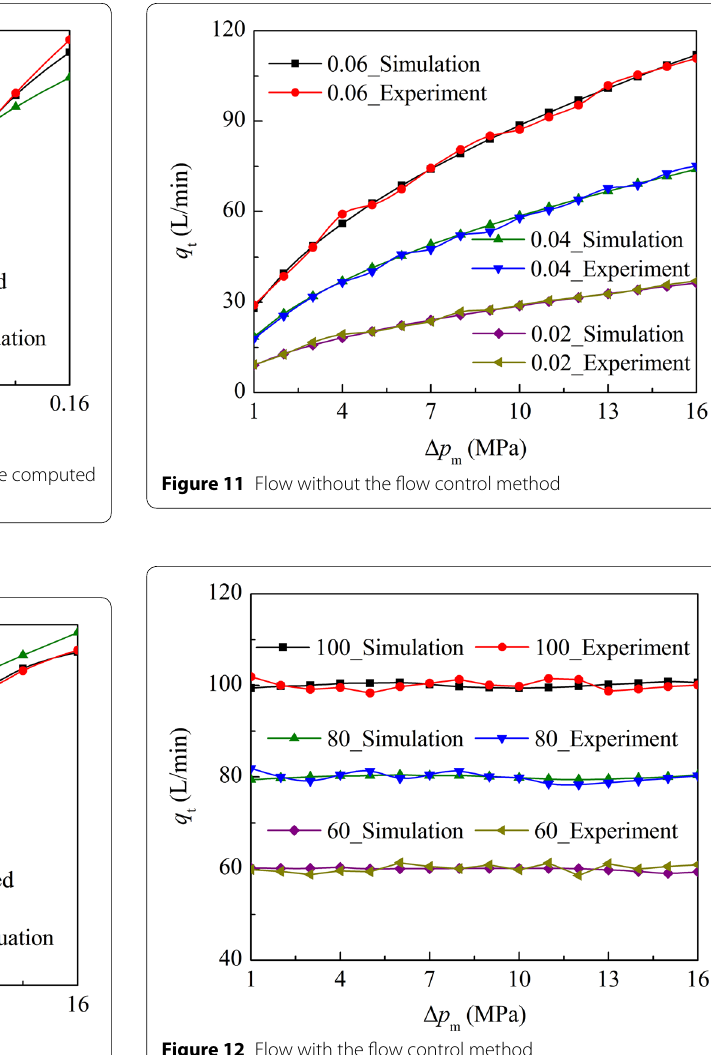
Figure 10 Comparisons between the inferred data and the computed data in case 2